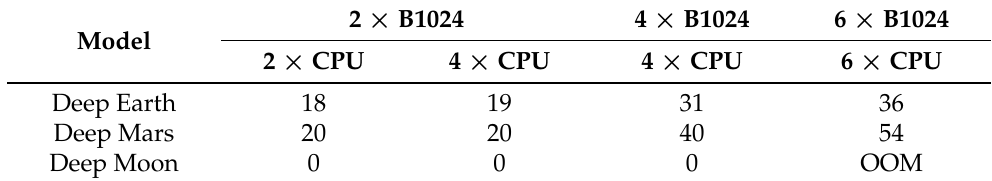
Table 16. Multi-Stream benchmark results (max number of streams) for B1024 DPU architecture.